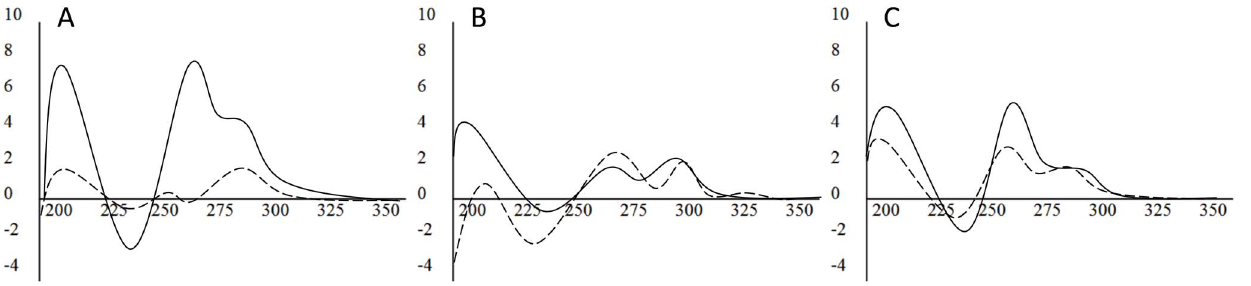
Figure 2. Circular dichroism spectroscopy of putative MEST promoter region G4s. CD spectra of G4MEST1 (A), G4MEST2 (B), and G4MEST3 (C). Molar ellipticity (x10 5 deg.cm 2 .dmol 2 1 ) is on the vertical axis and wavelength (nm) is on the horizontal axis. Solid lines represent the CD spectra at 25 ˚ C in the presence of 50 mM KCl and dashed lines represent CD spectra in the presence of 50 mM